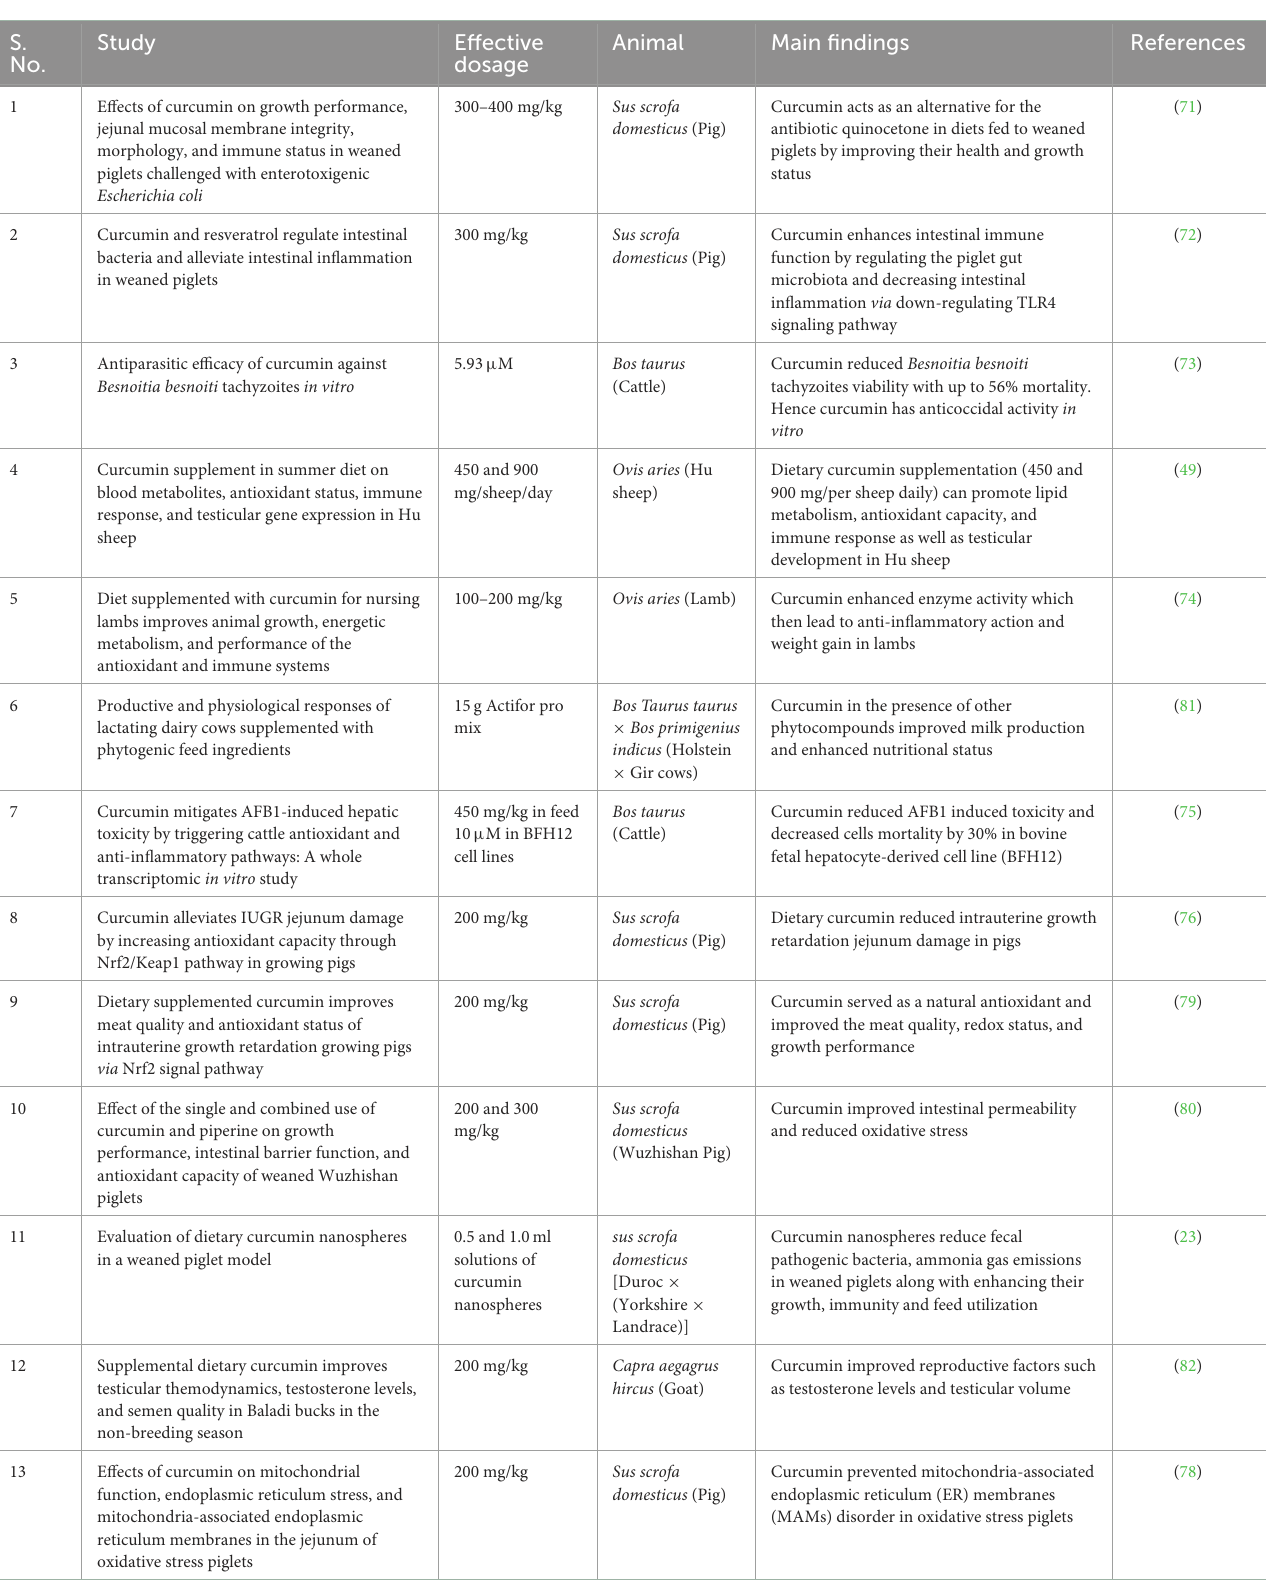
TABLE 1 The described effects of curcumin supplementation in livestock animals. S.